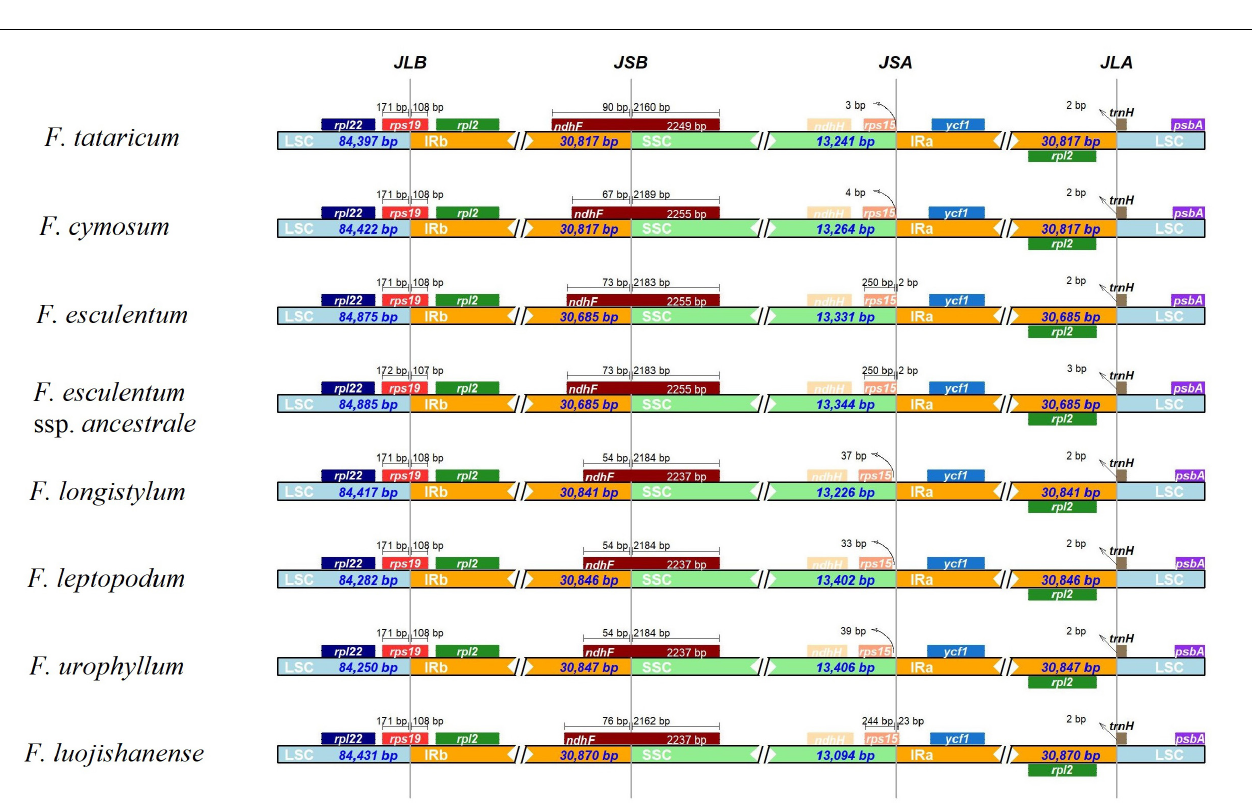
FIGURE 4 | Comparison of nucleotide diversity (Pi) values among the eight Fagopyrum species. X -axis, position of the midpoint of each window; Y -axis, nucleotide diversity (Pi) of each window.